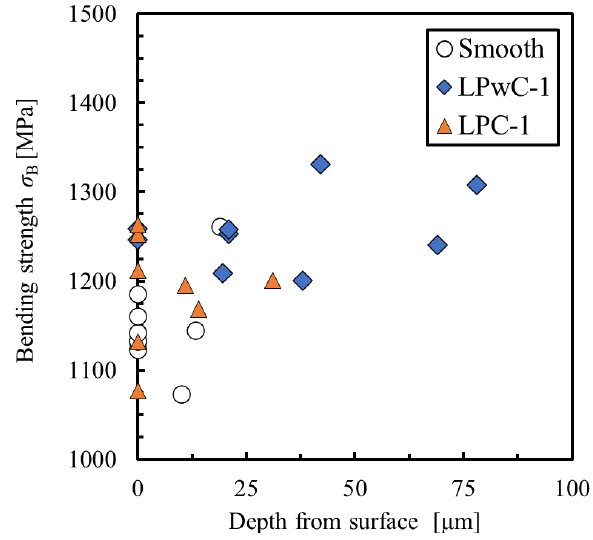
Figure 12. Relationship between bending strength and depth of fracture origin from surface of the